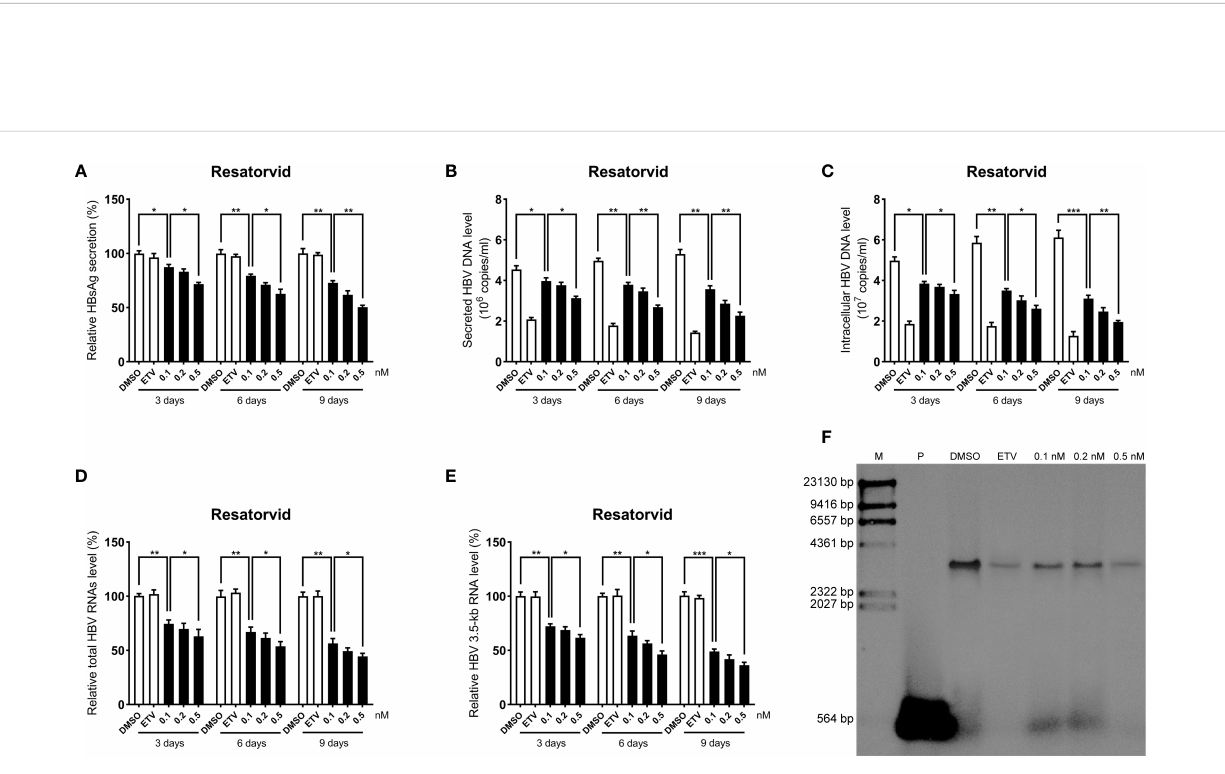
FIGURE 5 Resatorvid inhibited HBV replication in HepAD38 cells. HepAD38 cells were treated with 0.1% DMSO, 0.1, 0.2, or 0.5 nM resatorvid and 25 nM ETV for 3, 6 and 9 days. The levels of HBsAg, secreted and intracellular HBV DNA, and HBV RNAs were detected. (A) The results of the ELISA showed a decrease in the level of HBsAg in the supernatant. (B-E) Real-time PCR analysis showed that resatorvid inhibited HBV DNA both in the supernatant and cells, as well as, HBV total RNAs and 3.5-kb RNA. (F) A Southern blot analysis was performed to determine the level of HBV DNA after 9 days of treatment. *, P < 0.05; **, P < 0.01; ***, P <